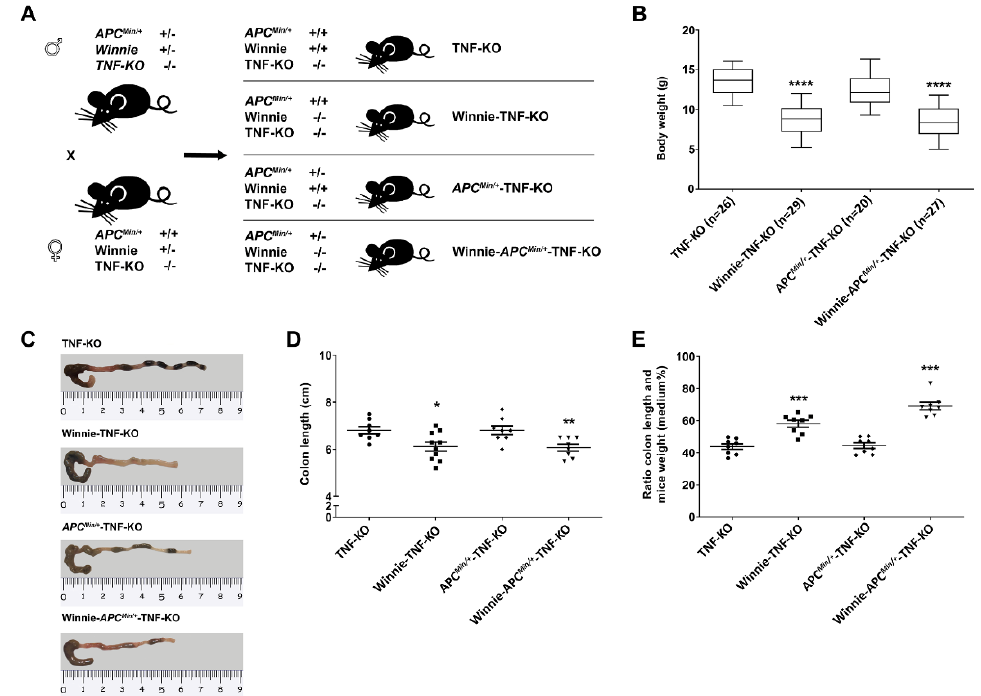
Figure 1. Creation and characterization of the Winnie- APC Min/+ -TNF-KO murine line. ( A ) Breeding strategy used to obtain Winnie- APC Min/+ -TNF-KO mice along with the control littermates. ( B ) Body weight analysis of 4-wk-old mice from different genotypes. Representative images of colons ( C ), data analysis of colon length ( D ), and colon length adjusted to the body weight ( E ) for Winnie- APC Min/+ -TNF-KO mice and control littermates. D-E: eight animals/group. Box plots represent the mean ± SEM. * p < 0.05, ** p < 0.01, *** p < 0.001, **** p < 0.0001 compared with TNF-KO mice. TNF: tumor necrosis factor.